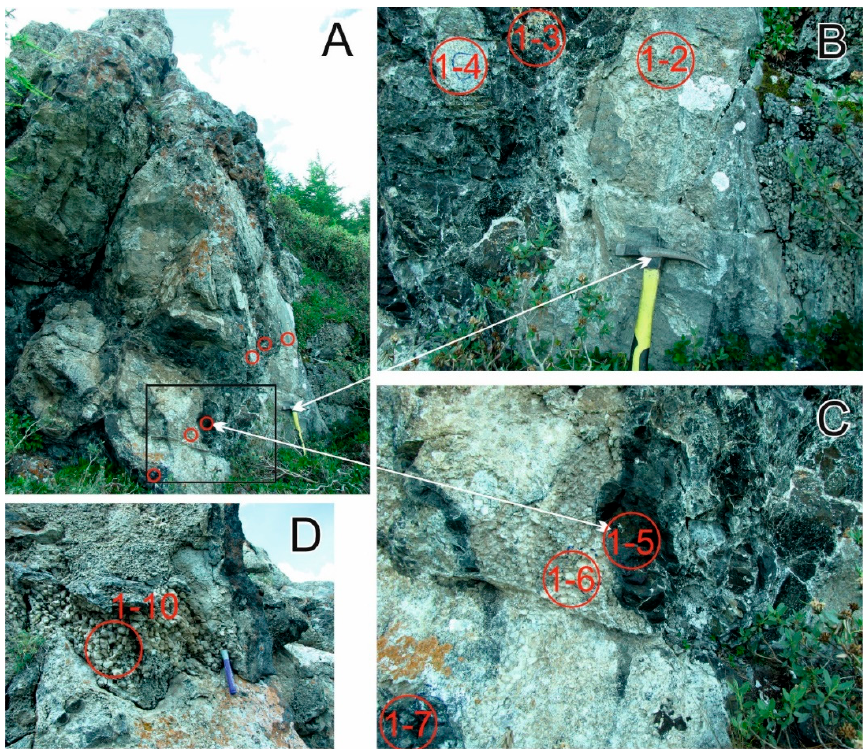
Figure 4. Representative photographs of a recrystallized marble xenolith in the contact zone of the Chik intrusion: ( A ) overall view, ( B – D ) detailed photos of sample locations. The numbered circles indicate the sampling numbers. These samples were used for the isotope analyses of oxygen and carbon in calcite (Appendix A).